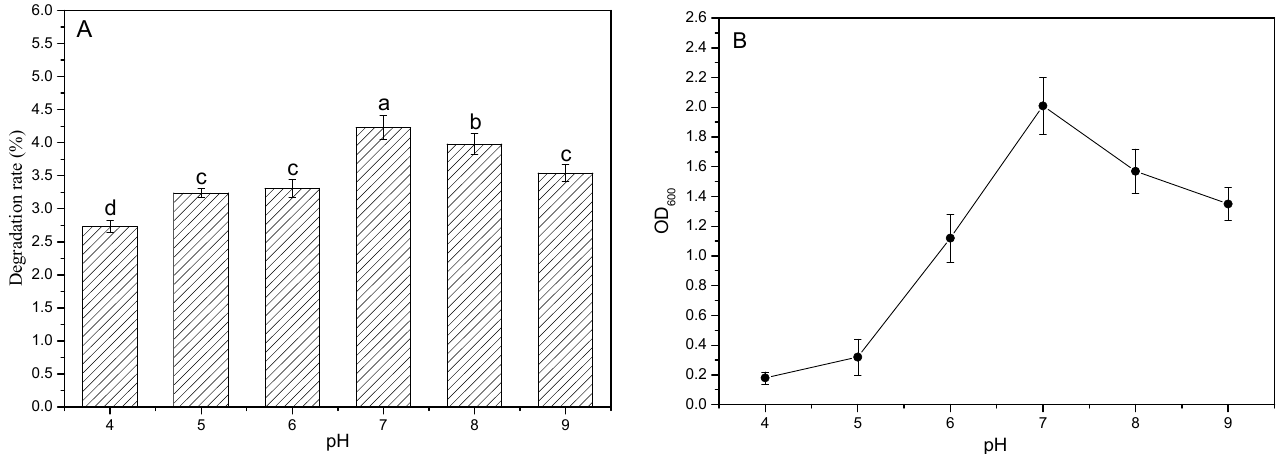
Figure 4. Effect of pH values on the degradation rate of PBAT film ( A ) and change of biomass (OD 600 ) in the medium ( B ); a-d are symbols indicating the significance of the difference.